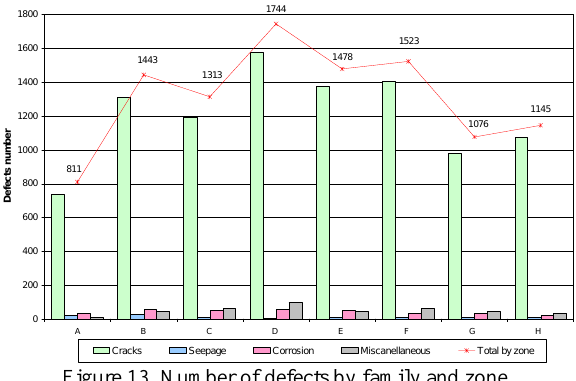
Figure 13. Number of defects by family and